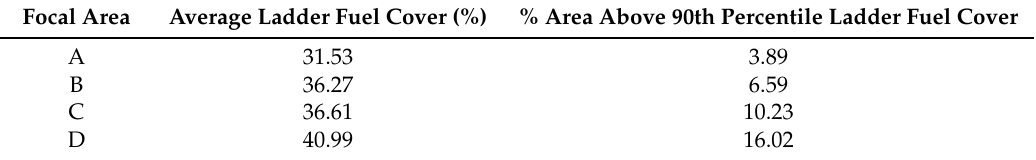
Figure 10. Ladder fuel cover, as predicted from the LiDAR point cloud using Equation (1), is displayed across the study area. Table 3. Average ladder fuel cover in the four focal areas, as well as the proportion of each focal area with ladder fuel cover in the top 10% (58%–100% ladder fuel cover) for the entire study area, are shown.